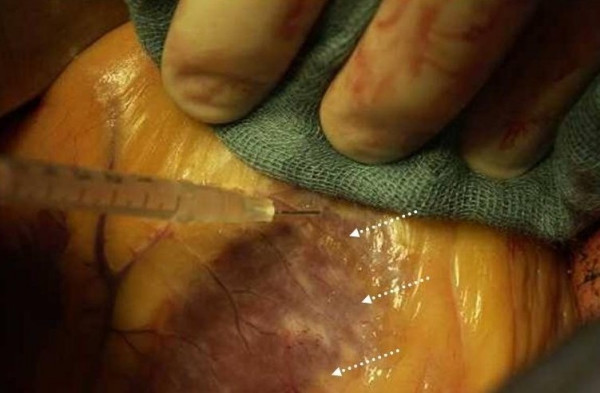
Mononuclear bone marrow cells were applied to the borderzone and the core area of the infarction (arrows).